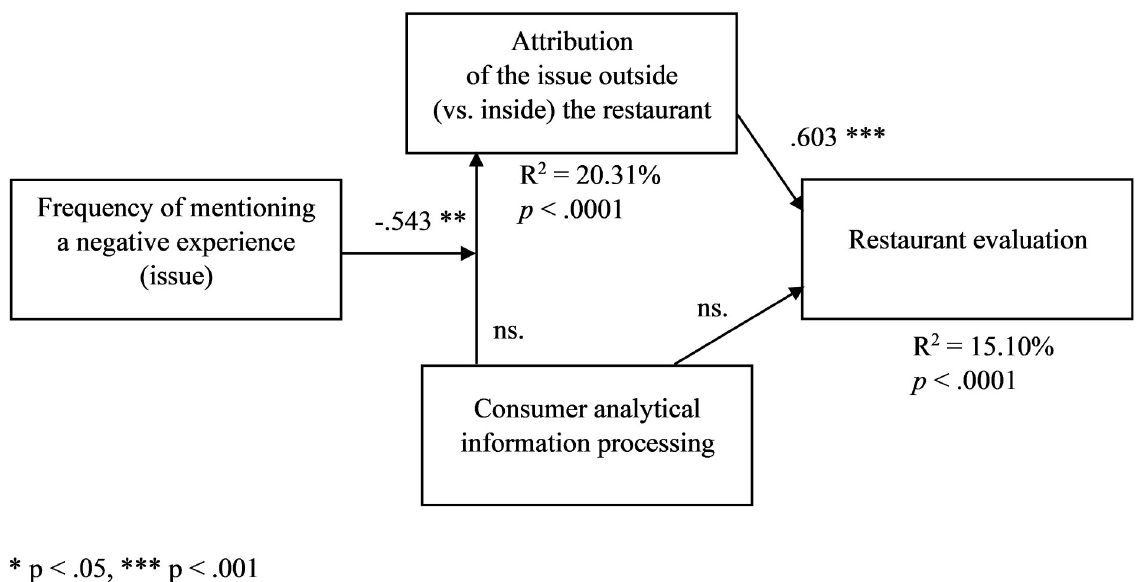
Fig 4. Frequency of mentioning a negative experience (issue) and the effect of consumer analytical information processing on the attribution of the issue outside (vs. inside) the restaurant, and restaurant evaluation–a moderated-mediation model (Study 1). The attribution cue condition is included as a covariate. � p < .05, ��� p <